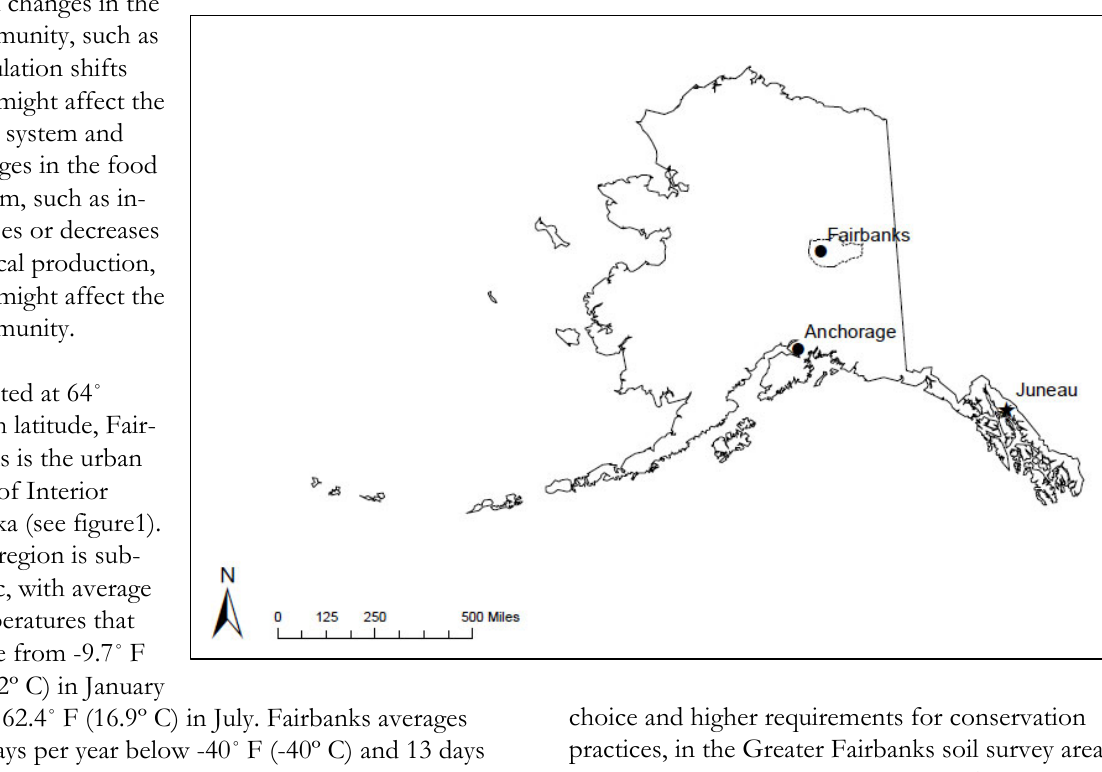
Figure 1. The State of Alaska, Fairbanks North Star Borough, and Urban